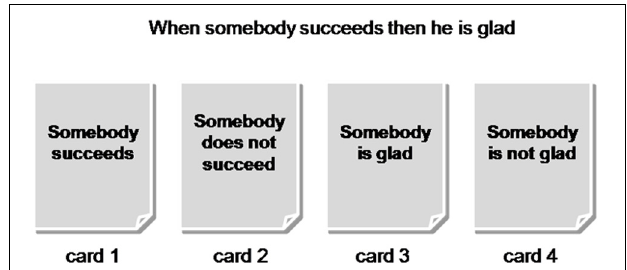
FIGURE 1 | Example of a WST problem with the four corresponding cards.